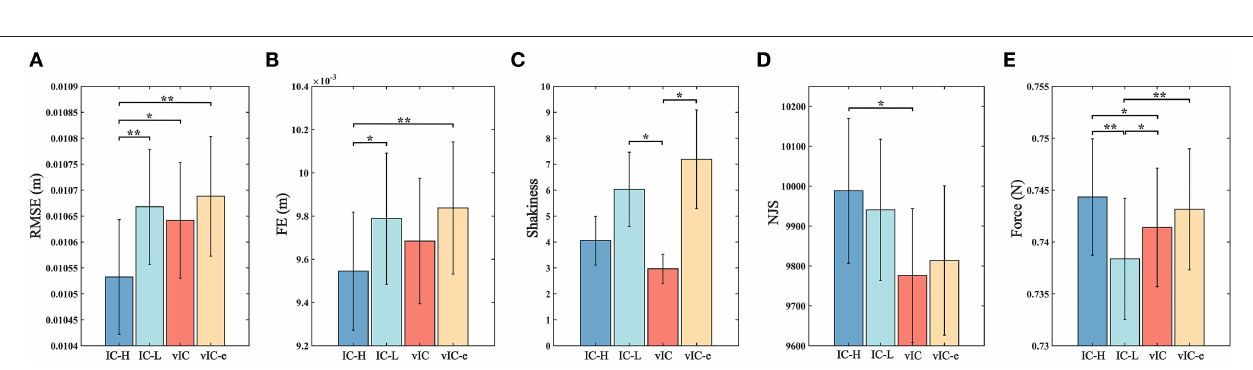
FIGURE 9 | The damping values of four control algorithms in the main motion axis during a rightward subtask. The maximum of damping values is 7 Ns/m (IC-H), while the minimum is 1 Ns/m (IC-L).